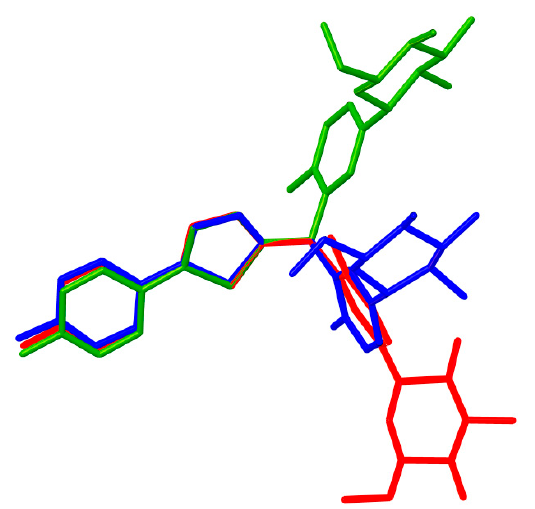
Figure 2. Molecules overlay of CG-Hemi (blue and red) and CG-H 2 O (green). H atoms have been omitted for clarity.